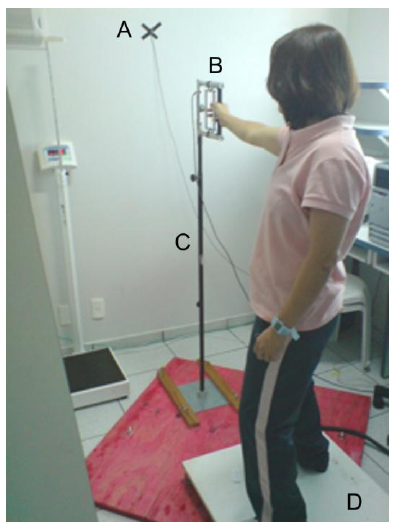
Figura 1. Posicionamento adotado pelo judoca simulando a técnica Jigo-Hon-Tai . A) LED; B) dinamômetro de preensão manual; C) pedestal e D) plataforma